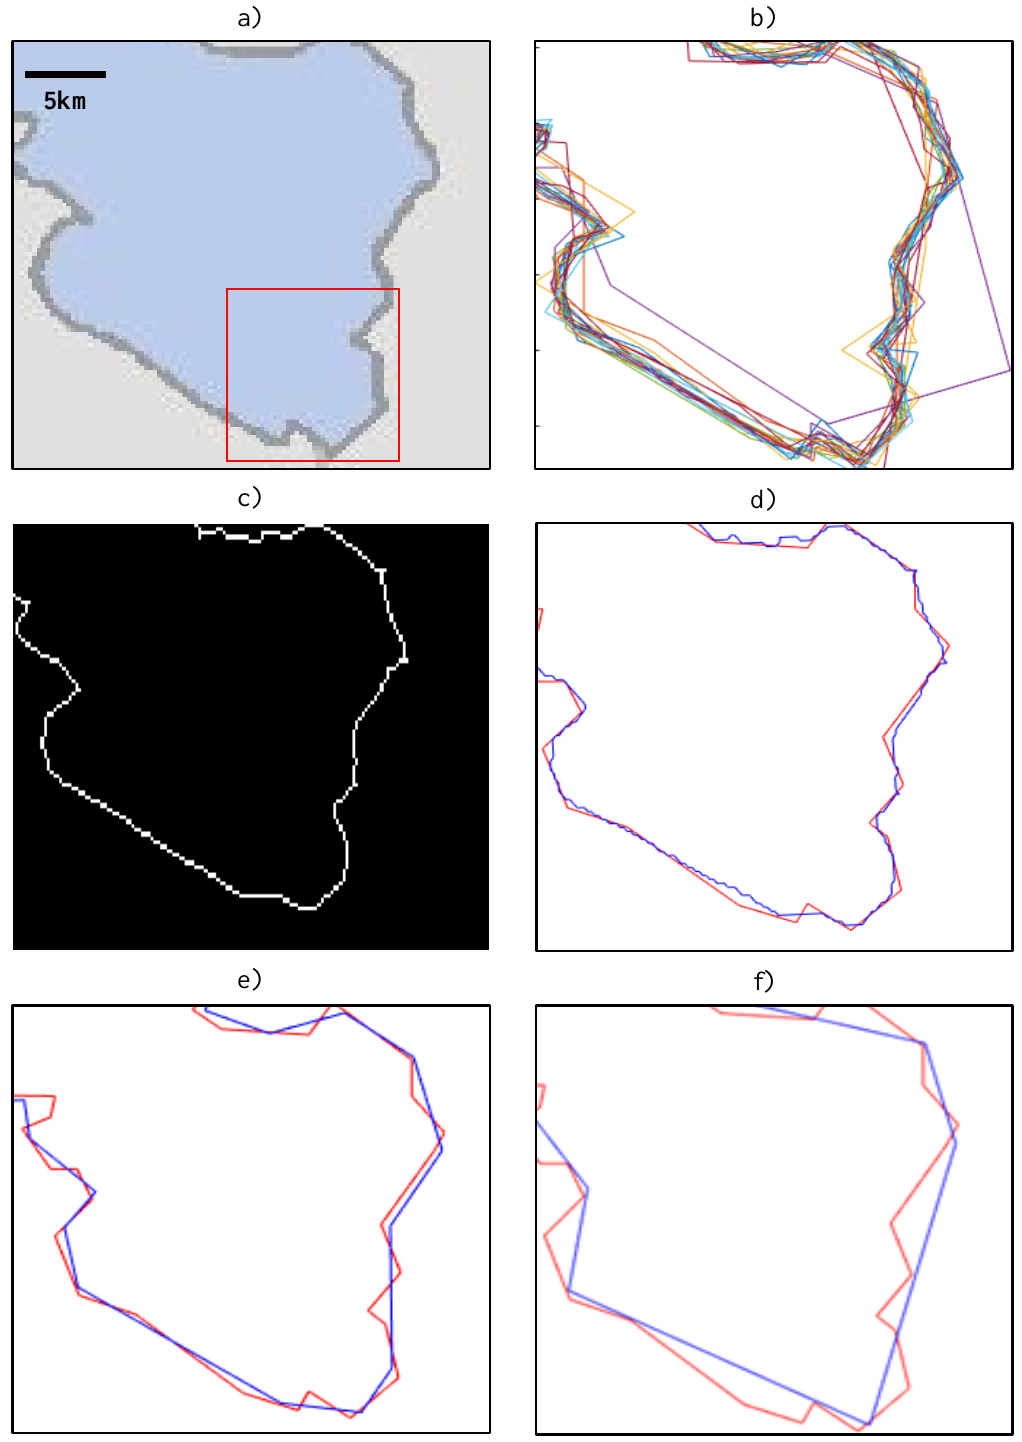
Figure 6. Results of the raster-based integration: (a) data source; (b) multiple data collection; (c) skeleton (d) result of the raster/vector-conversion in blue, reference data in red; (e) vector data smoothed with Douglas Peucker with buffer width 1000m in blue, reference data in red; (f) vector data smoothed with Douglas Peucker with buffer width 1000m in